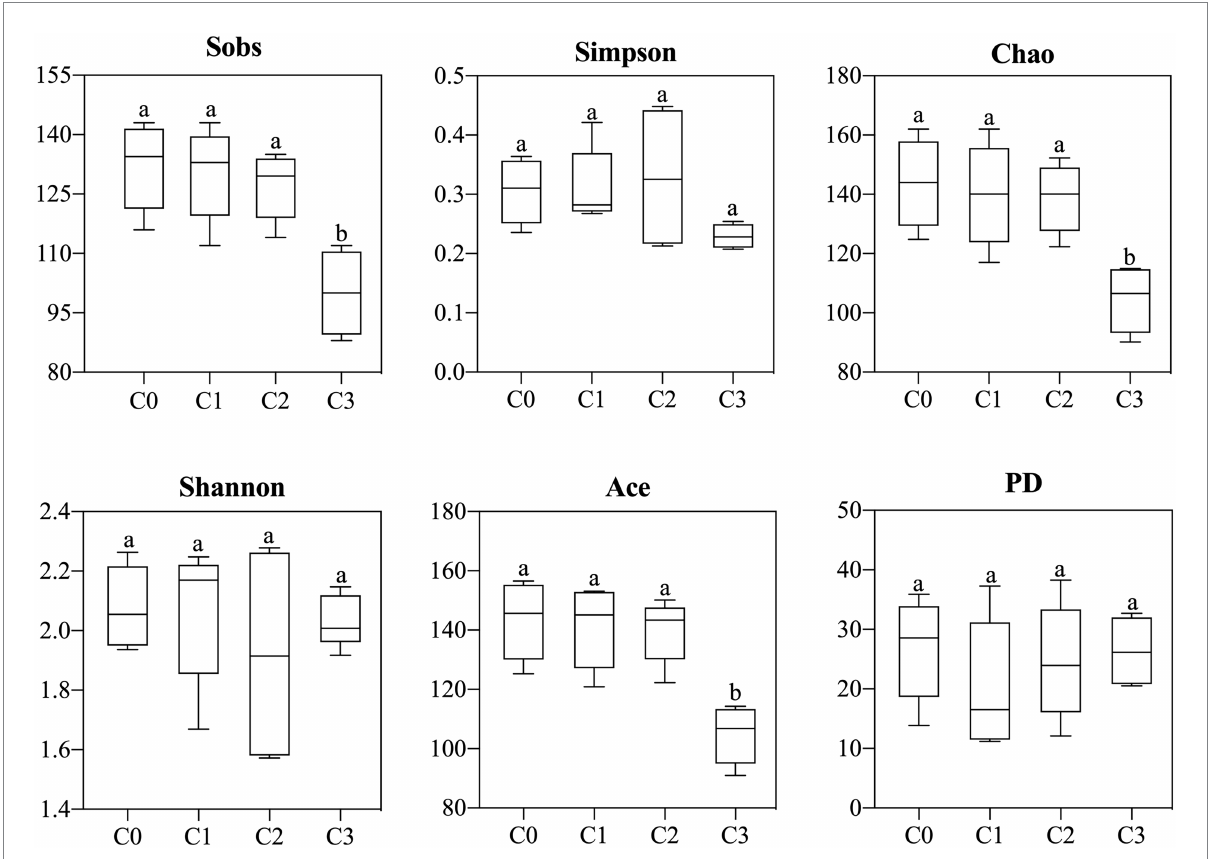
FIGURE 6 Effects of AVH-AgNPs on alpha-diversity indices of gut microbes of zebrafish. C0, C1, C2, and C3 refer to 0, 6, 9, and 18 μ g/l of AVH-AgNPs, respectively. Values are expressed as mean ± SE ( n = 3). Bars with different letters indicate significant differences ( p < 0.05).